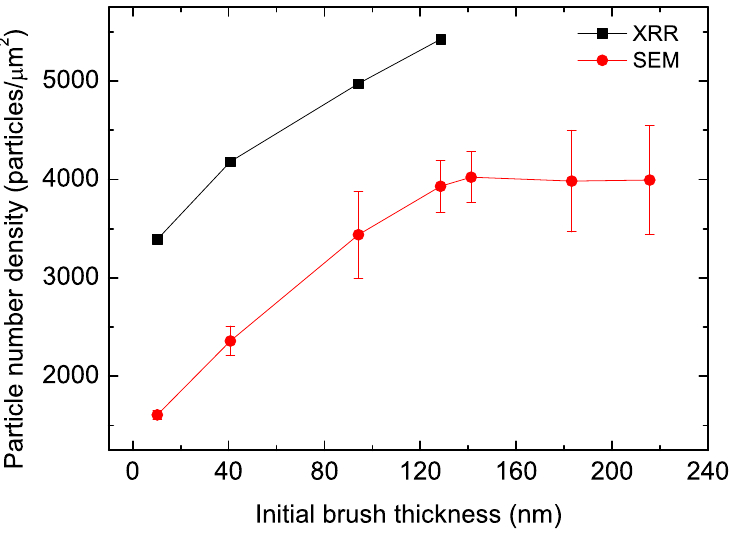
Figure 10. Particle number densities obtained by XRR (Layer 2) (squares) and SEM (circles) in dependence of PDMAEMA brush